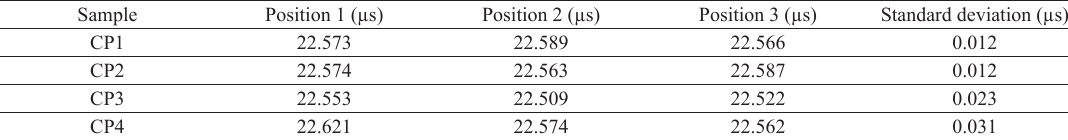
Table 1. Time of flight (µs) of the LCR wave in samples without defects. Sample